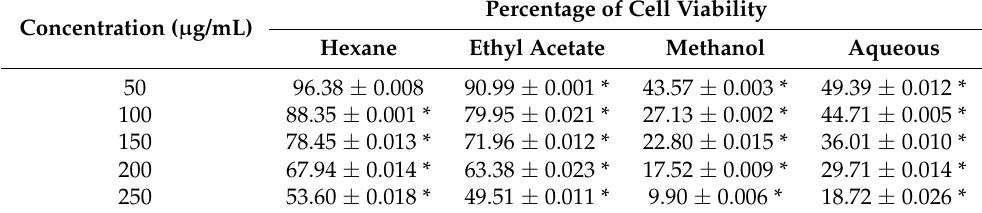
Table 2. Growth inhibitory activity of different solvent extracts of T. terrestris against Lung Cancer (A549) cell line.